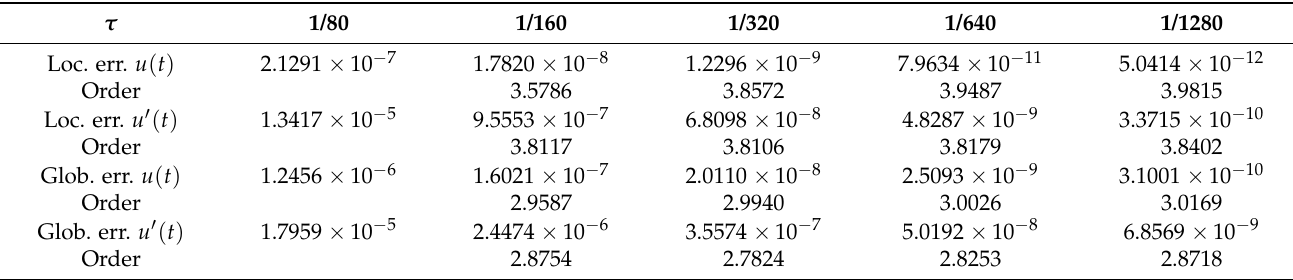
Table 8. Local and global errors and orders for problem (3) with RN3.